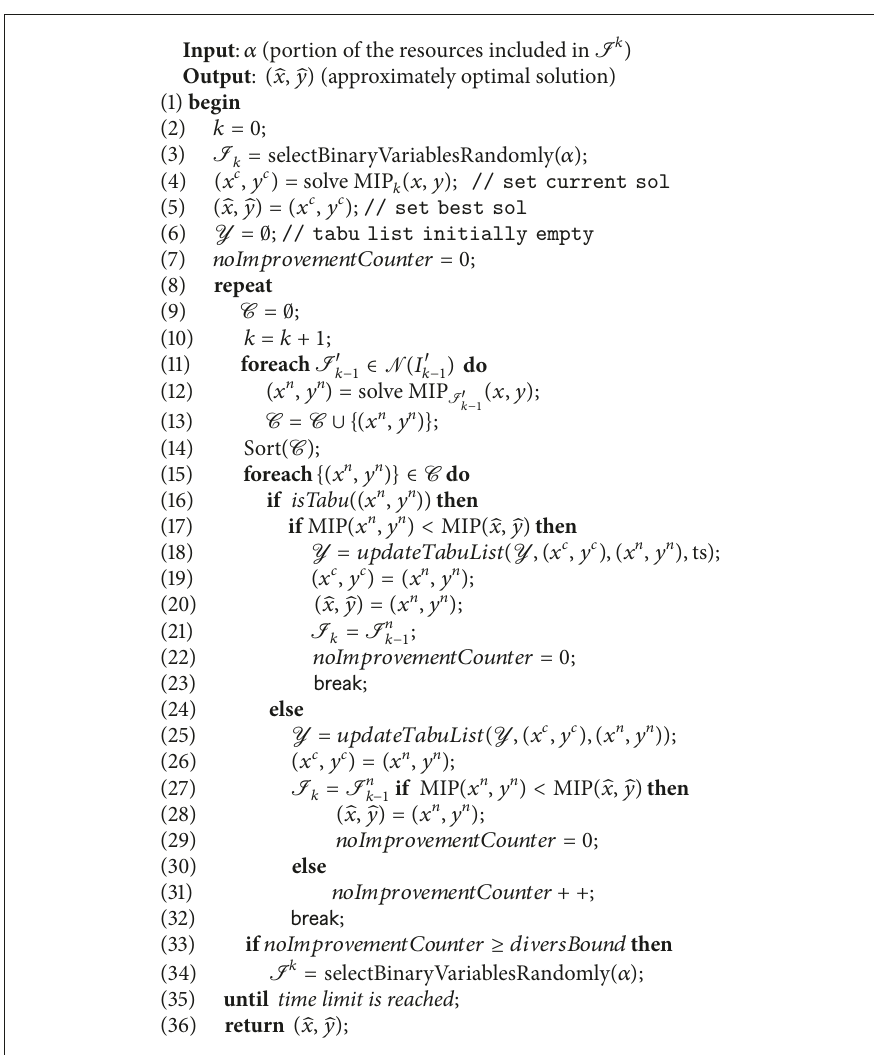
Algorithm 3: Tabu search algorithm.